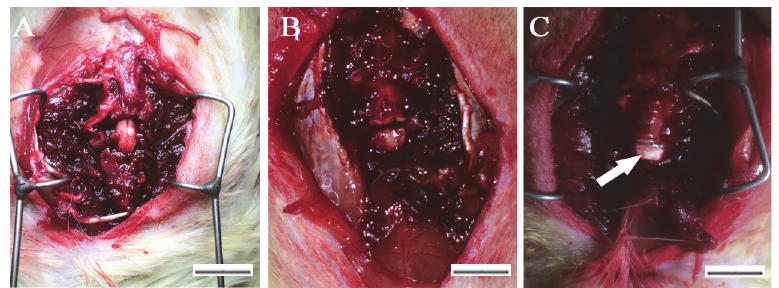
Fig 2. Surgical procedures of SCI. Spinal cord was transected after laminectomy at T10-11 level (A). A 2-mm spinal cord segment completely removed at T10 spinal cord level (B). Then, the 3D scaffolds of 2.0 mm in length with iNSCs were transplanted to the gap